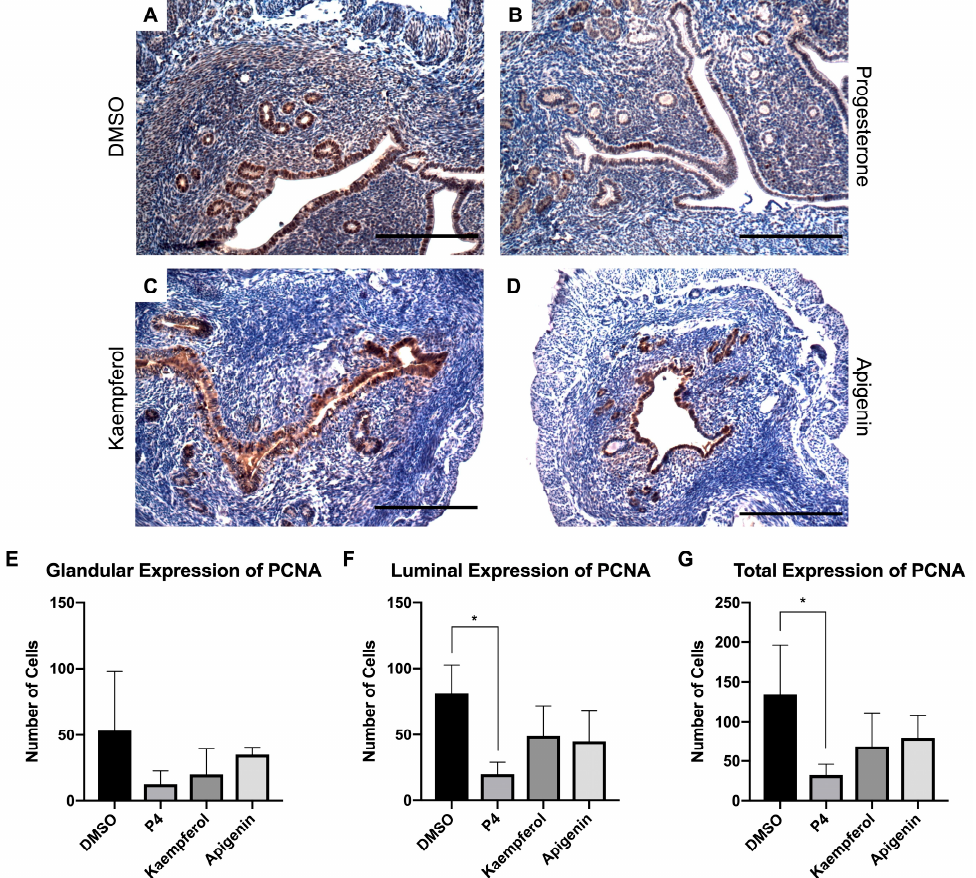
Figure 4. Kaempferol and apigenin did not inhibit luminal and glandular epithelial cell proliferation. Immunohistochemical staining against proliferation marker PCNA on uterine cross sections of control- ( A ), progesterone- ( B ), kaempferol- ( C , D ) apigenin-treated mice. Scale bar = 100 µ m; magnification 20 × . Quantification of the number of PCNA cells per treatment in representative images in the ( E ) glandular, ( F ) luminal, or ( G ) total epithelium. One-way ANOVA test was used to determine significance (* p < 0.05).